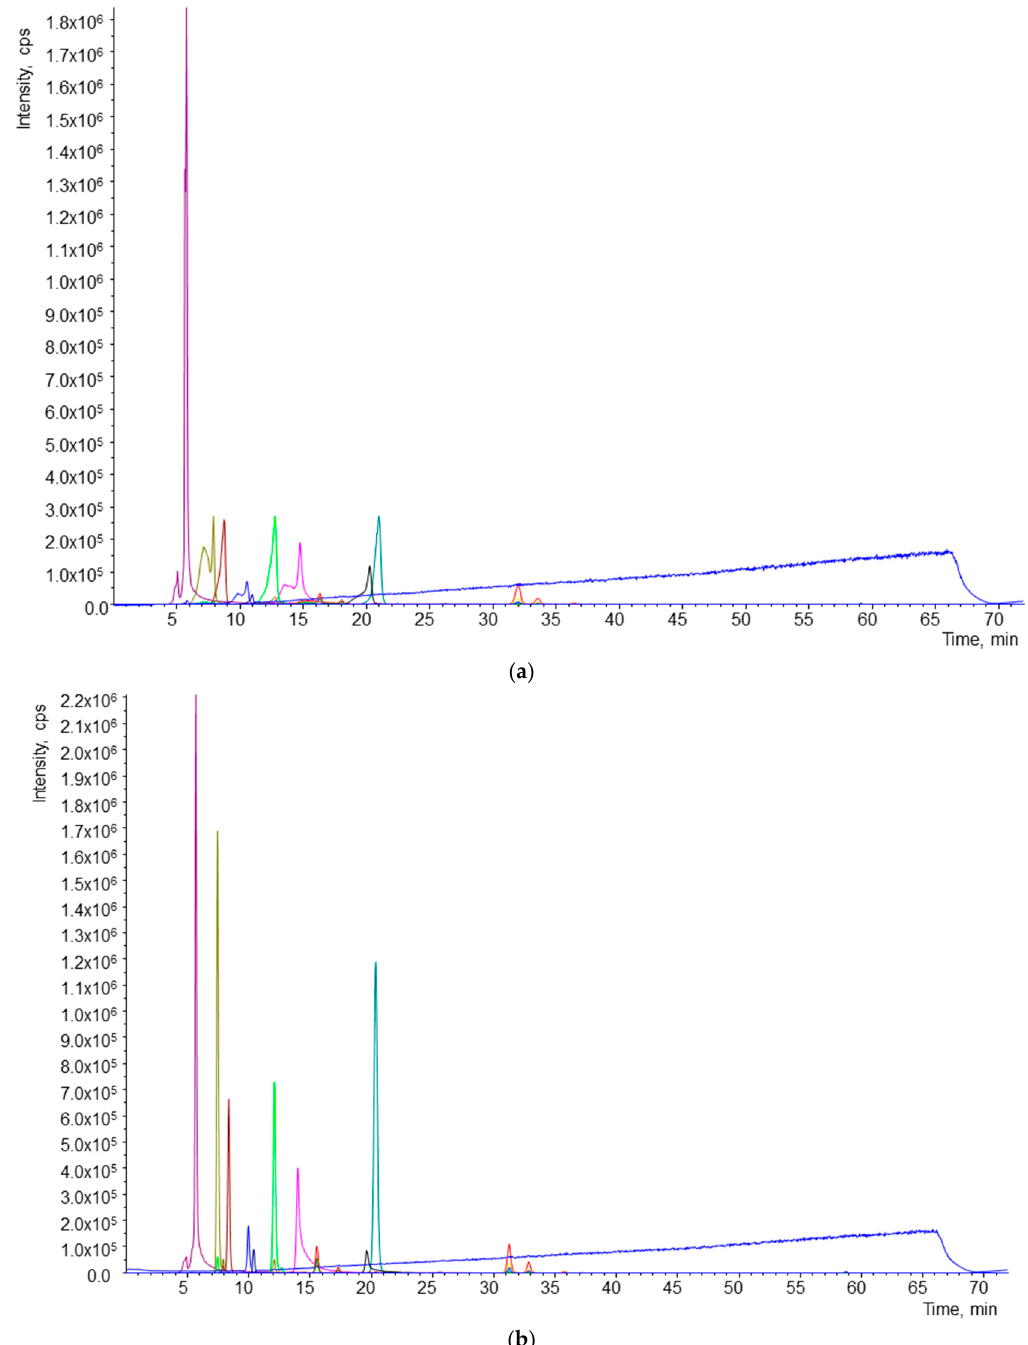
Figure 2. Effect of solvent used for reconstitution of samples. ( a ) Chromatogram of sample reconstituted in methyl tert -butyl ether (MTBE); ( b ) chromatogram of sample reconstituted in MeOH. Retention time (Rt) and optimal value for mass detection of declustering potential (DP), focusing potential (FP), entrance potential (EP), cell exit potential (CXP), and quantification transitions, with their corresponding collision energy (CE) are shown in Table 2.